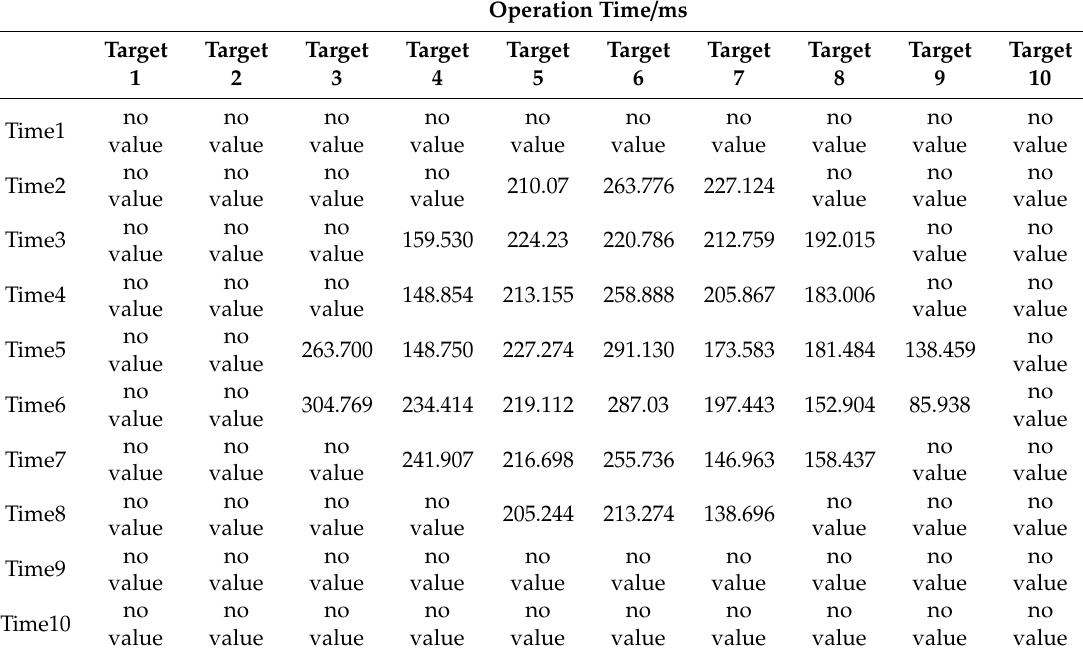
Table 3. The true temperature operation